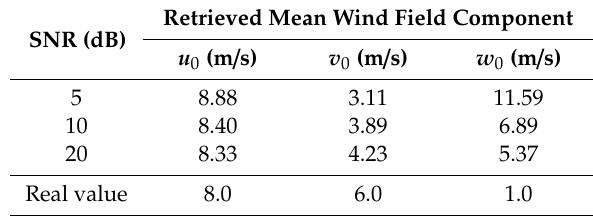
Table 2. Performance analysis of uniform wind field retrieval.